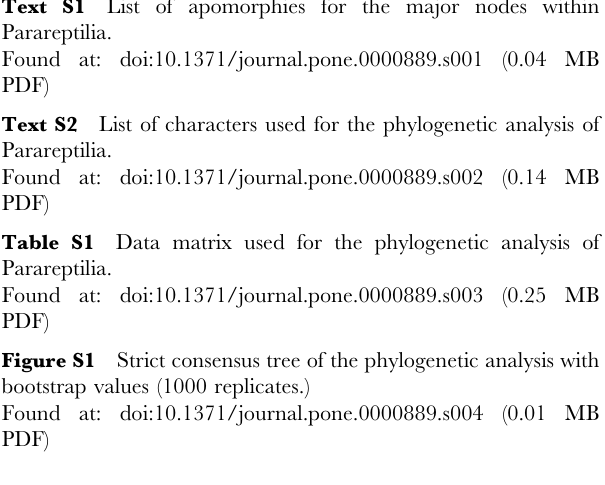
Figure S1 Strict consensus tree of the phylogenetic analysis with bootstrap values (1000